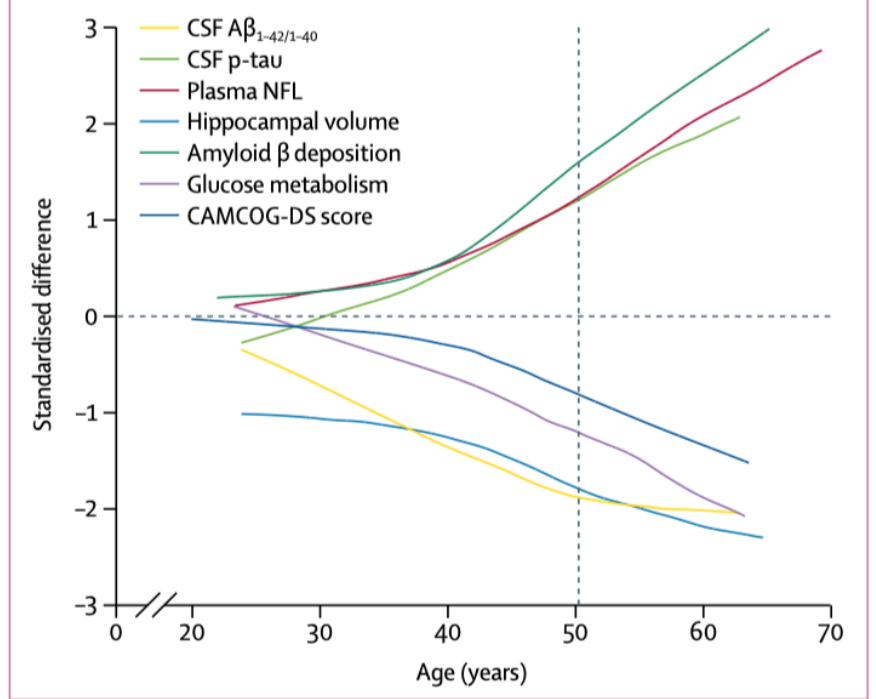
Figure 3. Integrated model of the natural history of AD in individuals with DS. Changes in structural, metabolic, and biochemical biomarker parameters as a function of age by use of the standardised differences between participants with DS and cognitively healthy controls fitted with a locally estimated scatterplot smoothing curve. Positive standardised differences represent higher biomarker values in participants with DS than in euploid controls, and negative values represent lower biomarker values. The vertical dashed line at 50·2 years represents the age at the expected symptom onset (median age of prodromal Alzheimer’s disease diagnosis). CAMCOG-DS (Cambridge Cognitive Examination for Older Adults with Down Syndrome) comprises brief neuropsychological tests used to measure cognitive decline. NFL = neurofilament light chain. p-tau = tau phosphorylated at threonine 181. From Fortea et al.,[165] 2020 . CSF (cerebrospinal fluid).